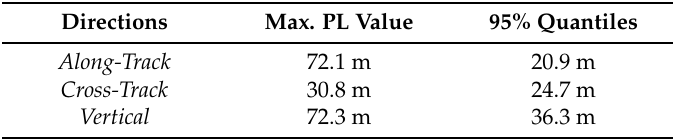
Table 1. Summary of the obtained LPL values on the demonstration